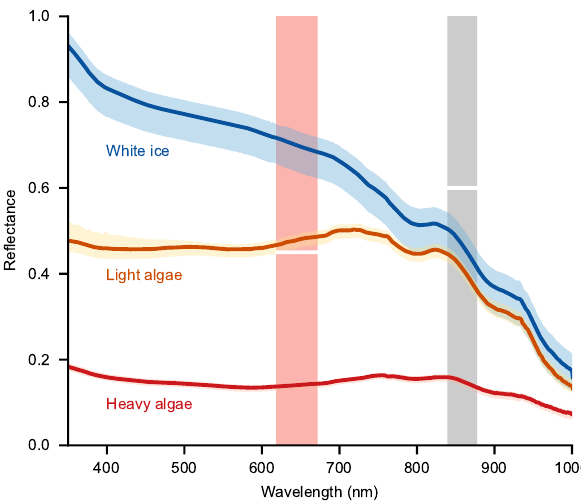
Figure A1. Field HCRF spectra acquired on the GrIS (see Ap- pendix A). For each surface type, solid lines denote mean re- flectance and the shaded bounds are delimited by the minimum and maximum reflectances. The grey shaded box corresponds to MODIS Band 2 (841–876nm) and the red shaded box to MODIS Band 2 (620–670nm). White divisions in each box correspond to the spectral thresholds utilised in this study to define bare and dark ice